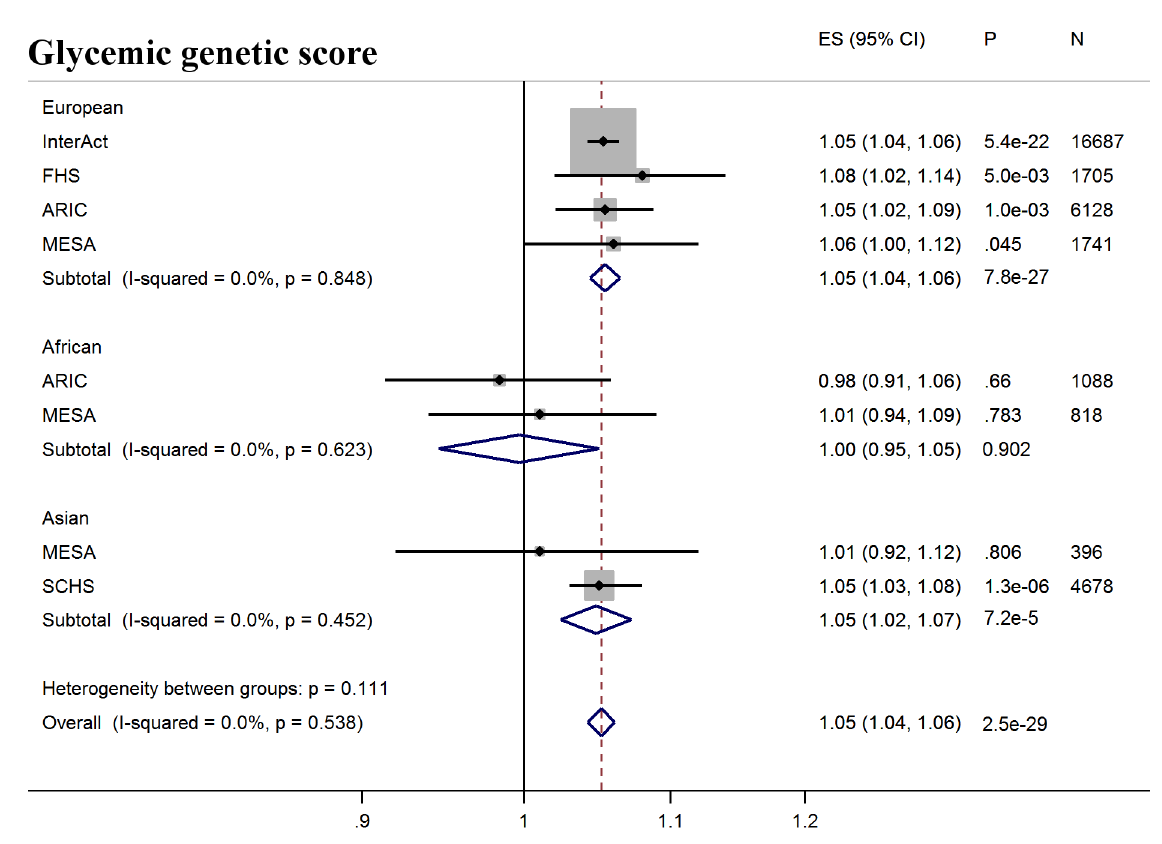
Fig 2. T2D prediction, glycemic genetic score. Forest plot of associationbetweenglycemicgenetic score with incident T2D over a decade-longfollow-upperiod, by ancestry. MESA (European and Asian ancestry) and the G6PD variant (rs1050828)in ARIC (European and African American) were not includedin the discovery GWAS analysis. Effect estimates were combinedin a fixed effects meta-analysis. Overall effect estimate: 1.05, 95% CI 1.04–1.06, p = 2.5 × 10 − 29 . ARIC, Atherosclerosis Risk in Communities Study; ES, Effect Size; FHS, FraminghamHeart Study; GWAS, genome-wide association study; G6PD, glucose-6-phosphate dehydrogenase; I-Squared, Higgin’sI-squared statistic, a measureof heterogeneity; MESA, Multiethnic Study of Atherosclerosis; SCHS, SingaporeChineseHealth Study; T2D, type 2